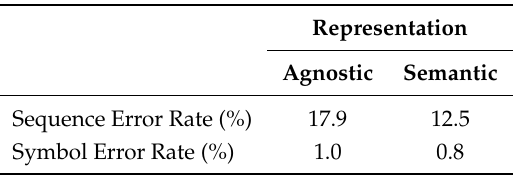
Table 4. Evaluation metrics with respect to the representation considered. Results reported represent averages from a 10-cross validation